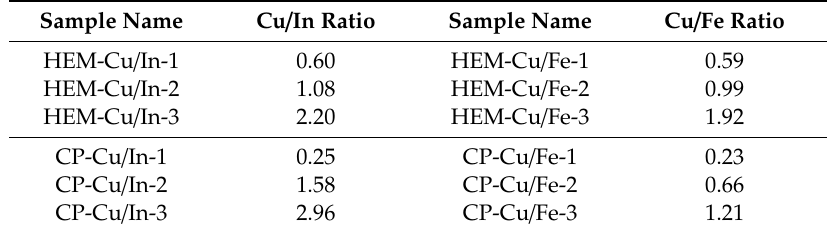
Composition of Mixed-Oxide samples prepared by High Energy Milling (HEM) or Co-Precipitation (CP), listed by molar